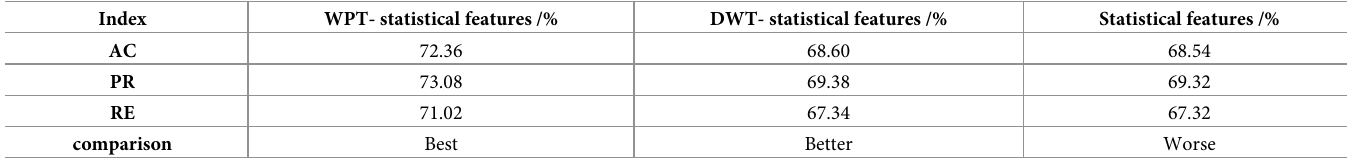
Table 5. Disturbance information extraction performance comparison for algorithms using different feature extraction